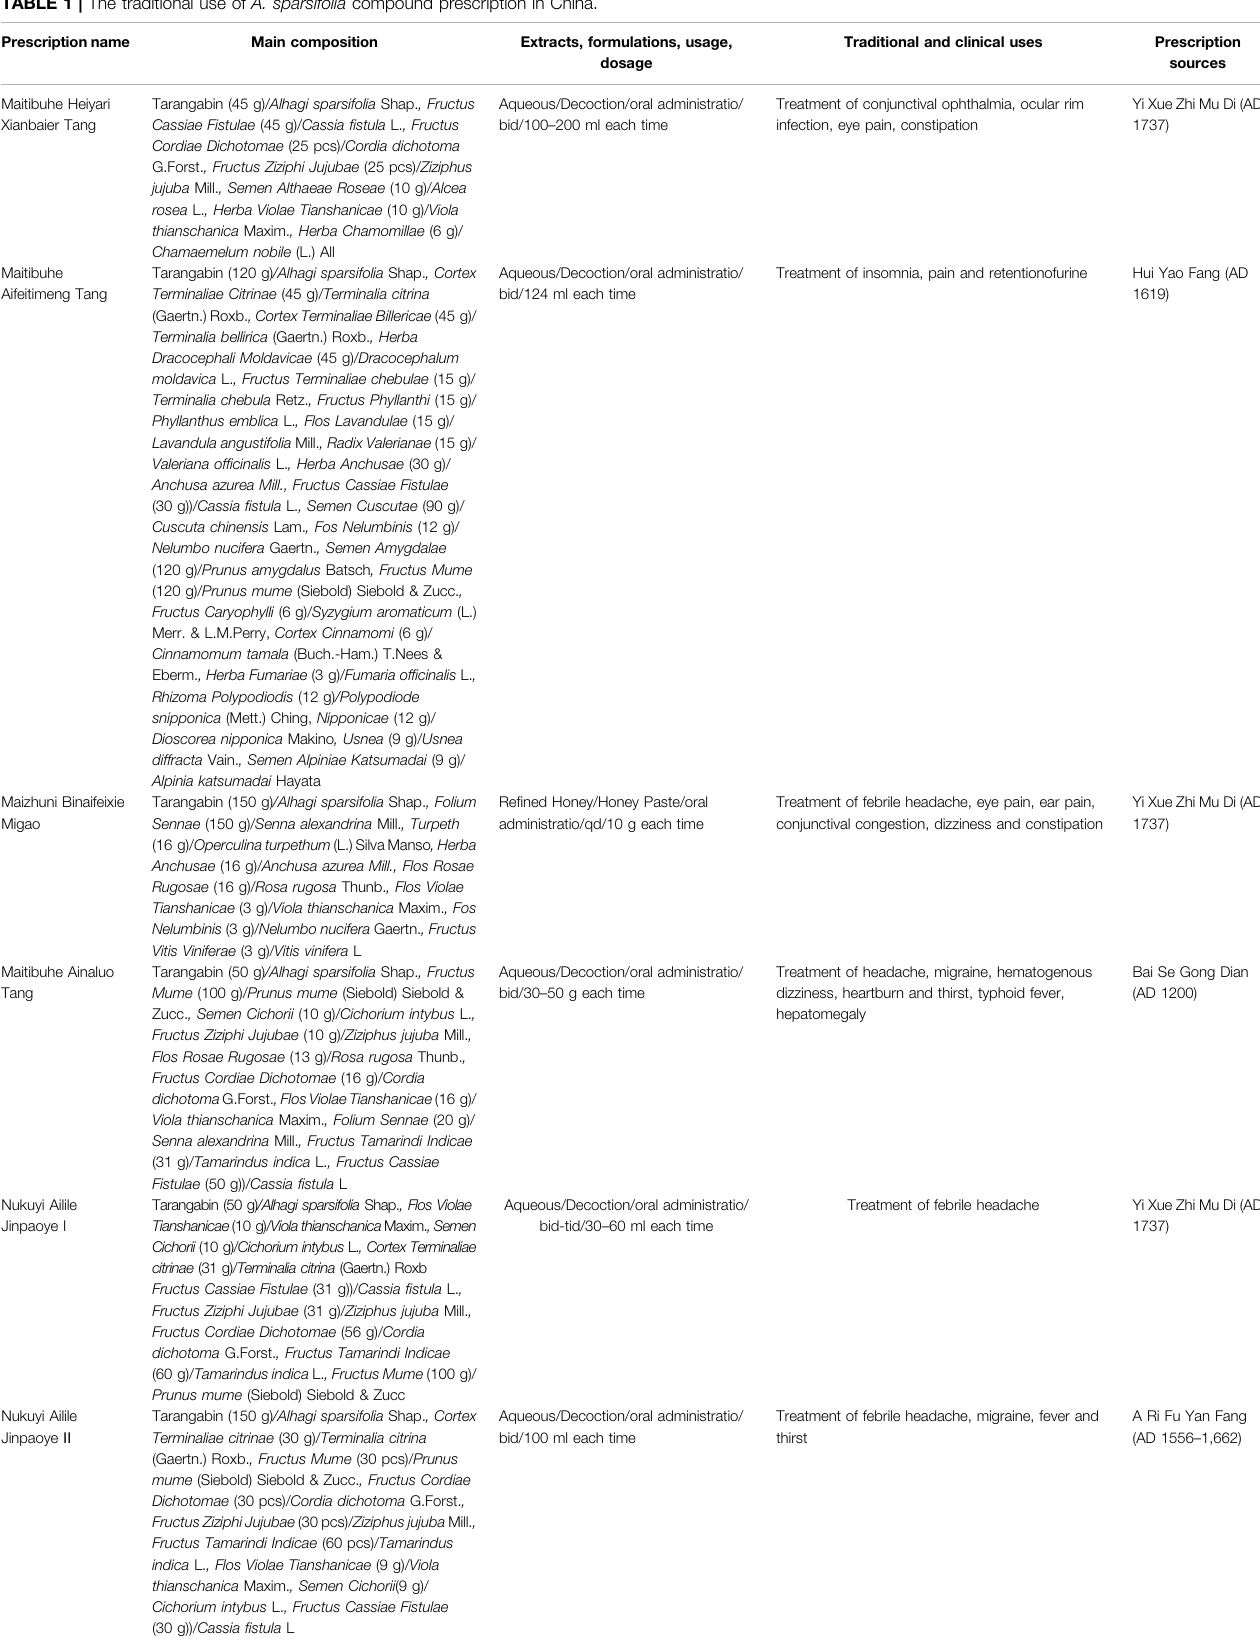
TABLE 1 | The traditional use of A. sparsifolia compound prescription in China.